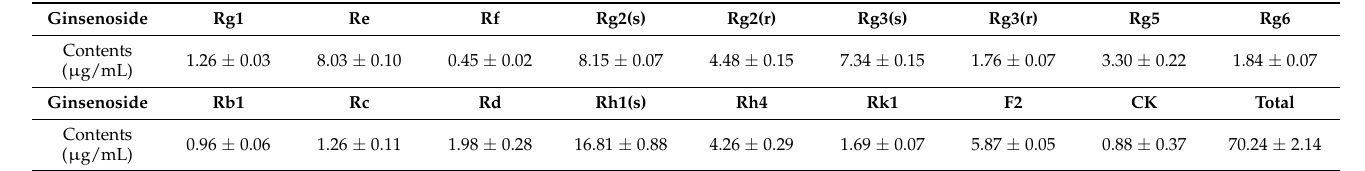
Table 1. Content ( µ g/mL) of ginsenosides of ginseng berry kombucha